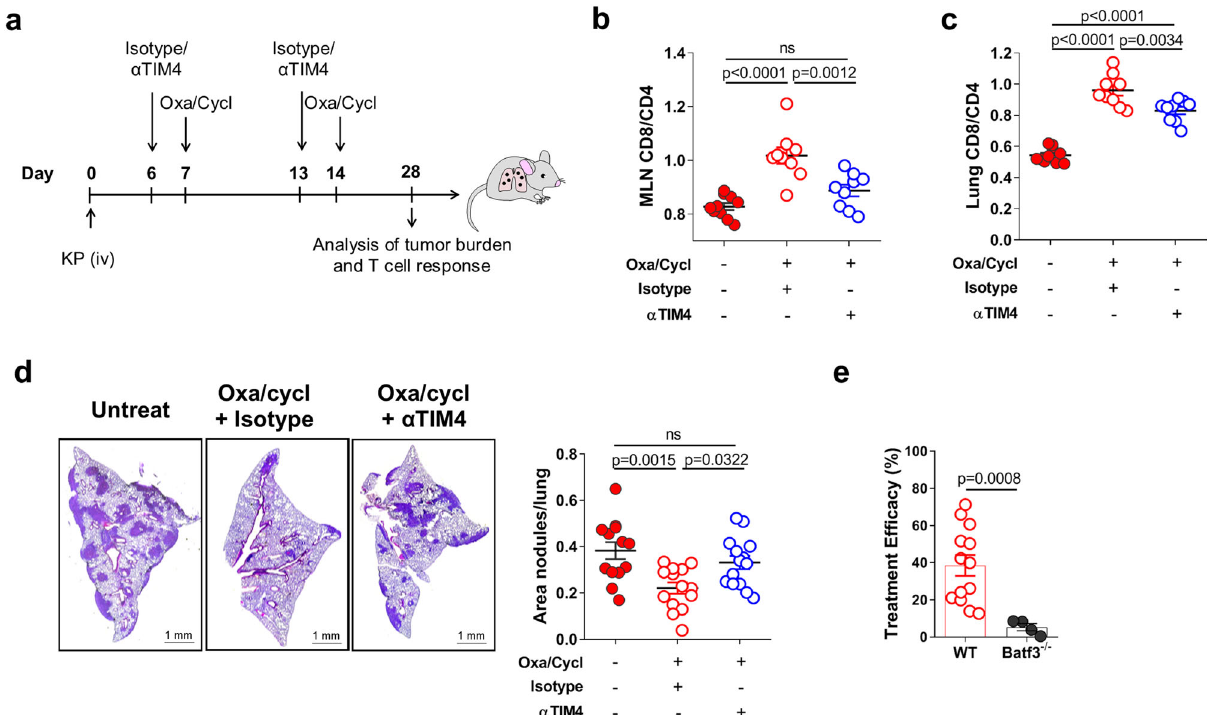
Fig. 6 TIM4 is required for tumor rejection induced by immunogenic chemotherapy. a Scheme of experimental design. Mice were challenged with KP cells and left untreated or treated with oxa/cycl and anti-TIM4 or isotype as depicted in the scheme. b , c Analysis of the CD8/CD4 T cell ratio in the MLNs ( b ), Untreated n = 10, Oxa/Cycl + Isotype n = 9, Oxa/Cycl + α TIM4 n = 9; and in the lungs ( c ), Untreated n = 10, Oxa/Cycl + Isotype n = 10, Oxa/Cycl + α TIM4 n = 9; of mice 2 weeks after the last treatment. Data are from two independent experiments. d Effect of TIM4 blockade on the ef fi cacy of the immunogenic chemotherapy. Tumor burden was assessed at day 28 by calculating the area covered by tumor nodules on four consecutive sections of three lobes/animal and expressed as a function of the total lobe area. Results are from untreated n = 13, Isotype + Oxa/Cycl n = 14 and Oxa/Cycl + α TIM4 n = 14 in two independent experiments. e WT and Batf3 − / − mice were challenged with KP cells and treated with oxa/cycl or left untreated. Treatment ef fi cacy is expressed as the percentage of reduction in tumor area over not treated control calculated in 14 WT and 4 Batf3 − / − mice. All data are expressed as mean ± SEM. Signi fi cance was determined by one-way ANOVA followed by Tukey ’ s post-test for b – d and two-tailed Mann – Whitney test in e . Source data are provided as a Source Data fi